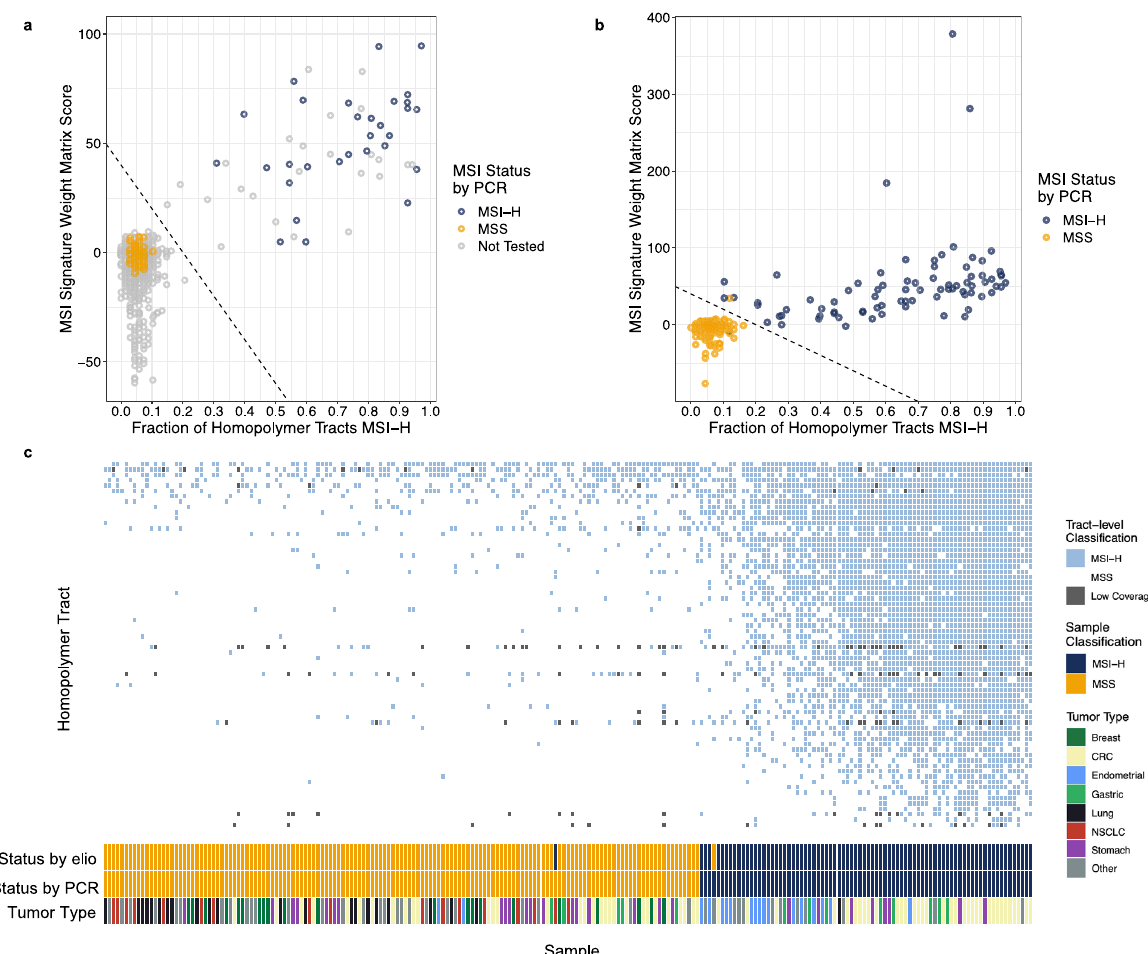
Fig. 5 Training and analytical validation of the elio tissue complete MSI detection algorithm. a 725 FFPE cancer samples were evaluated using the combination tract-based and substitution score microsatellite instability (MSI) algorithm. A subset of these samples ( n = 73) had con fi rmed MSI status through multiplex PCR analyses. After plotting both the fraction of positive homopolymer tracts and the signature weight matrix score, a decision boundary was determined to separate the cluster of known microsatellite stable (MSS) cases from known microsatellite instability-high (MSI-H) cases. Analysis for the presence or absence of deleterious mutations in genes involved in mismatch repair was used to segregate the population of samples close to the decision boundary line. b An independent cohort of 223 FFPE cancer samples with con fi rmed MSI status was analyzed with the elio tissue complete MSI algorithm. c Detailed analyses of each of the 68 mononucleotide tracts employed in the tract-based peak fi nding algorithm demonstrated >40% of tracts have perfect speci fi city in MSS cases and that a combination of high-sensitivity and high-speci fi city tracts was employed in the peak fi nding algorithm. Source data are provided as a Source Data fi le. CRC colorectal cancer, NSCLC non-small cell